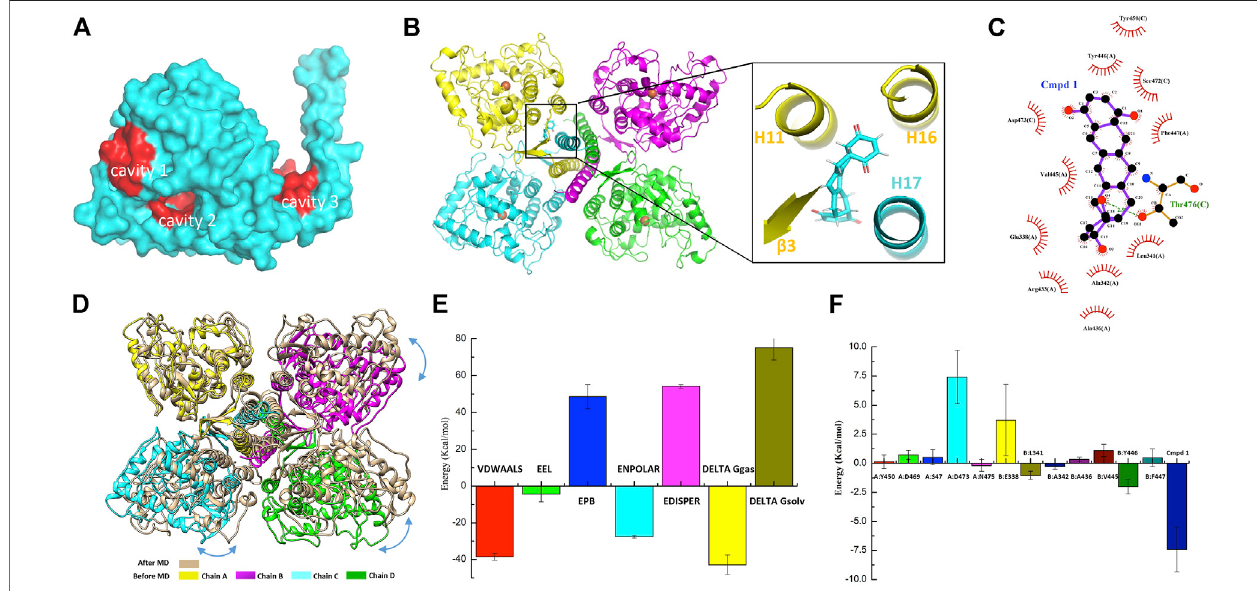
FIGURE4| Small-moleculescreeningbasedonthecryo-EMstructureoftryptophanhydroxylase2(TPH2). (A) representativecavitiesofTPH2predictedusingthe CavityPlusweb server. Thecavity zoneswithhigh scoresforallostericsites arecolored red. (B) cartoon display ofTPH2 tetramerbinding withthe small-moleculeCmpd 1. Structure of Cmpd 1 was shown as sticks in the insert. (C) key residues are shown in the interaction analysis of Cmpd 1 and TPH2. (D) Structural alignment and conformational changesof Cmpd 1 – bound TPH2 structures before and after simulation. Doublearrow curves in blue color indicate the rotation of chains B – D with chain A as reference. (E) illustration of energy difference for the receptor – ligand complex. VDWAALS denotes the van der Waals energy, EEL denotes the electrostatic energy,ENPOLARdenotes thenonpolarsolvationenergy, and EPB denotes the Poisson – Boltzmann energy. (F) per-residuedecomposition energiesfor theTPH2 with Cmpd 1 bound after simulation using